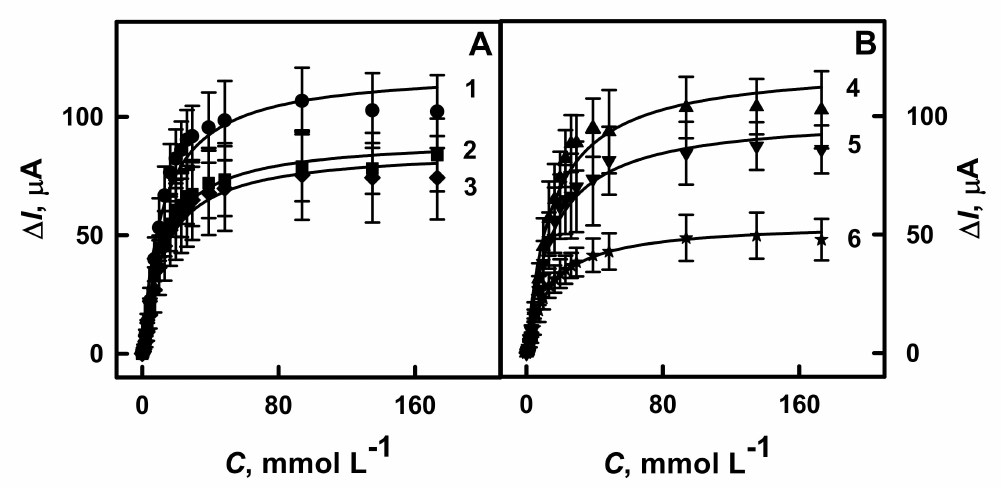
Figure 3. Calibration plots of glucose biosensors based on GR electrodes modified by polymer nanocomposites with the following additional enrichment by GOx: ( A ) PANI-AuNPs (6 nm) -GOx/GOx or PANI-GOx/GOx and ( B ) Ppy-AuNPs (6 nm) - GOx/GOx and Ppy-GOx/GOx. Conditions: GR electrodes covered by PANI-AuNPs (6 nm) -GOx/GOx (1 line), PANI- GOx/GOx (2 line), Ppy-AuNPs (6 nm) -GOx/GOx (4 line) and Ppy-GOx/GOx (5 line). For comparison, GR electrodes modified with AuNPs (6 nm) -GOx (3 line) and GOx (6 line) were investigated. Amperometric responses were registered in